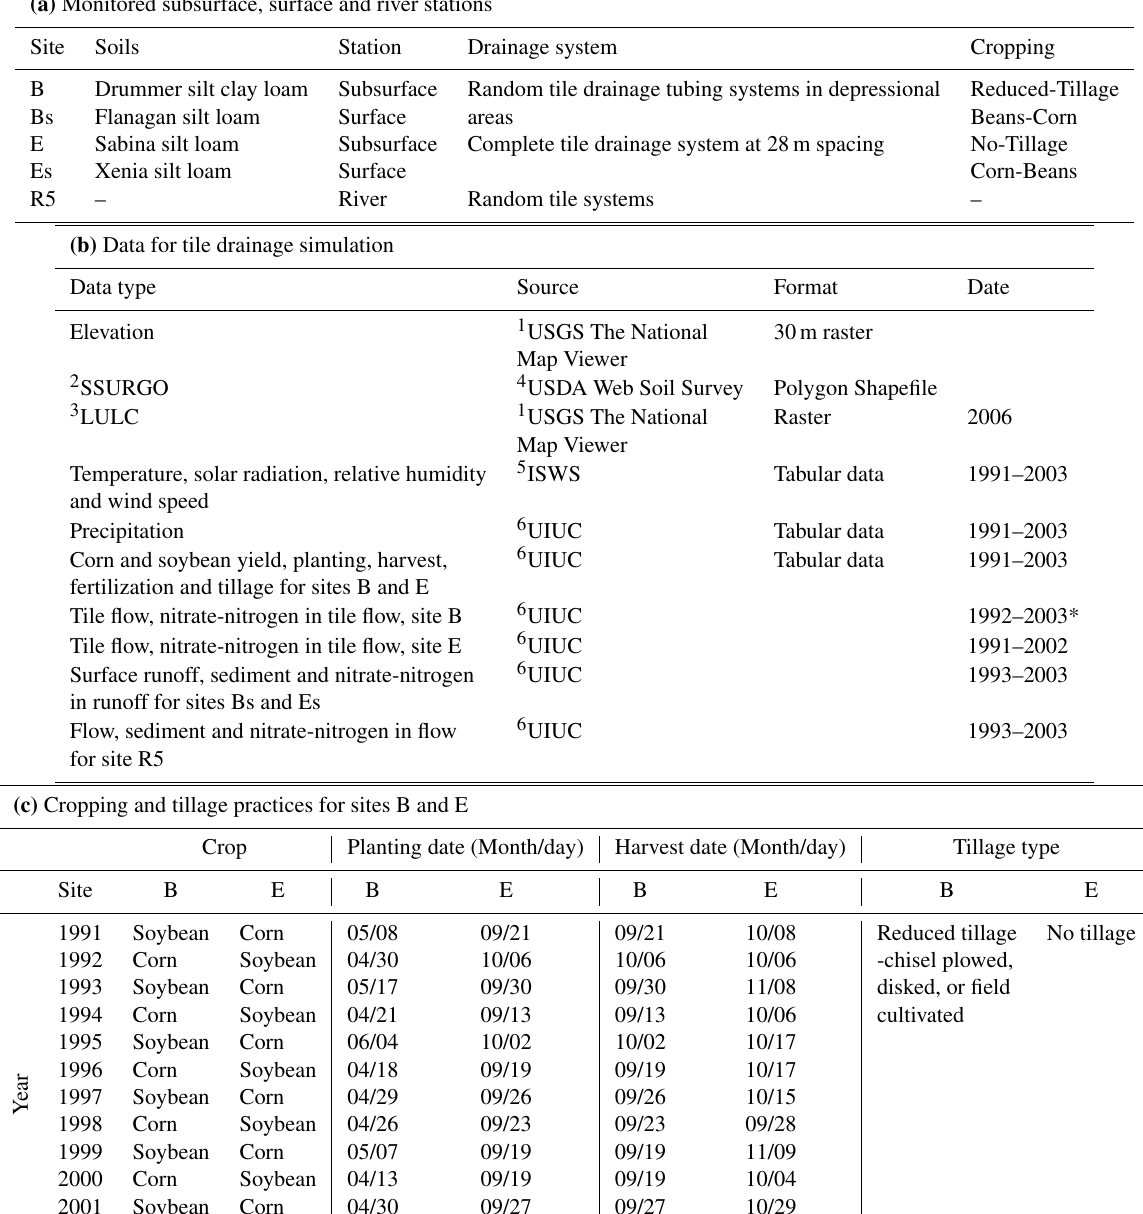
Table 1. Monitored subsurface, surface and river stations (a) , data for simulation in the LVR watershed (b) , and cropping and tillage practices for sites B and E (c) .